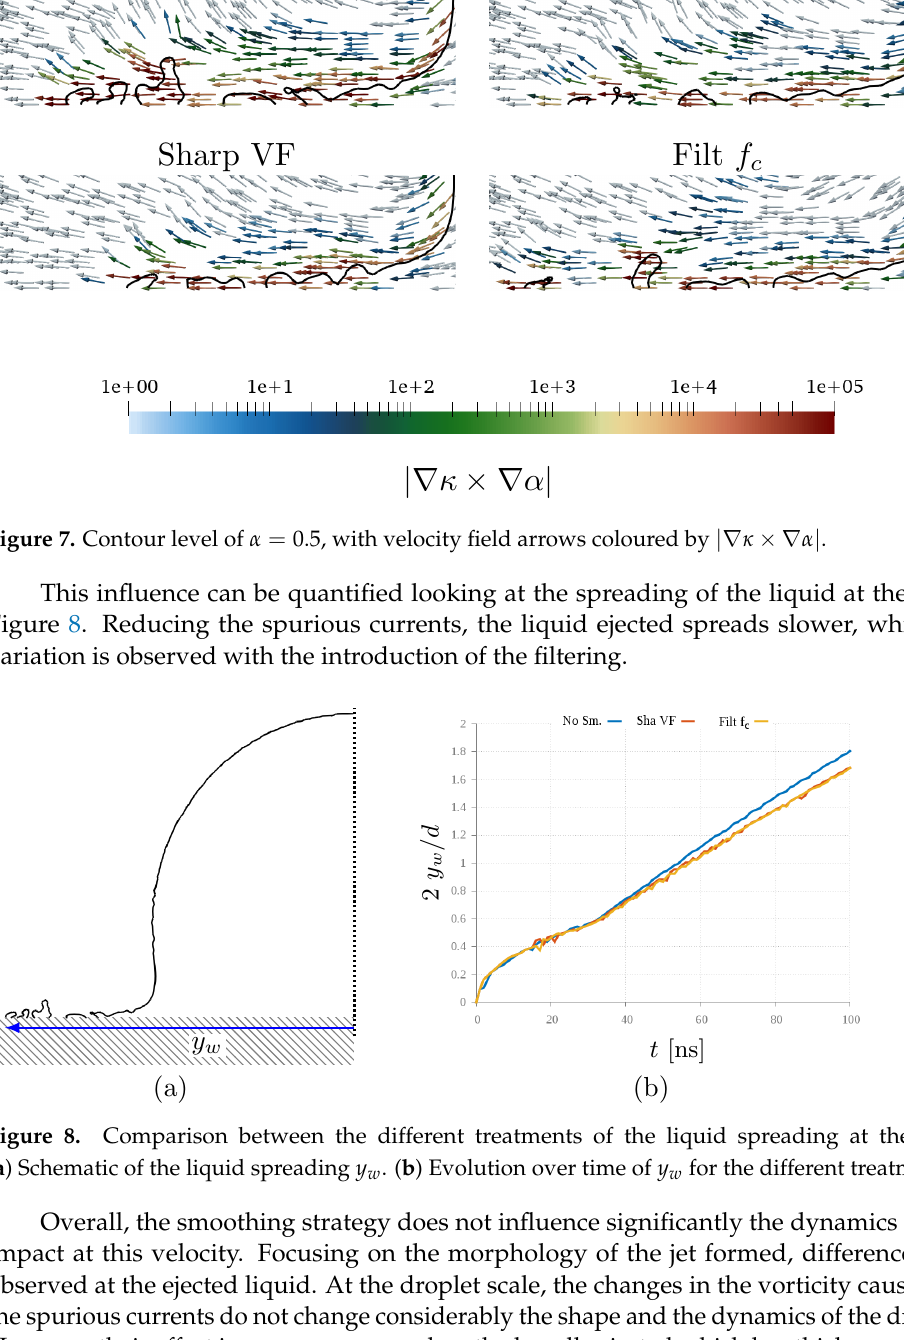
Figure 8. Comparison between the different treatments of the liquid spreading at the wall. ( a ) Schematic of the liquid spreading y w . ( b ) Evolution over time of y w for the different